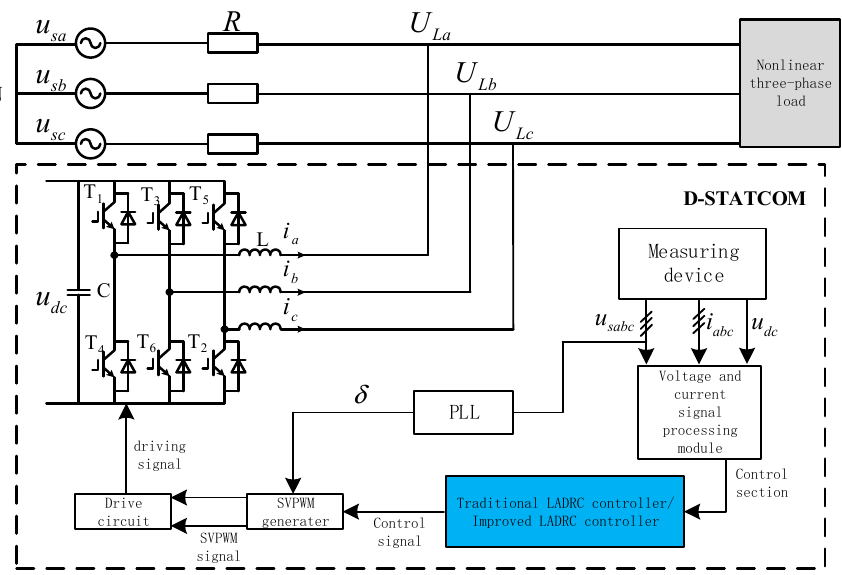
Figure 1. D-STATCOM structure diagram.